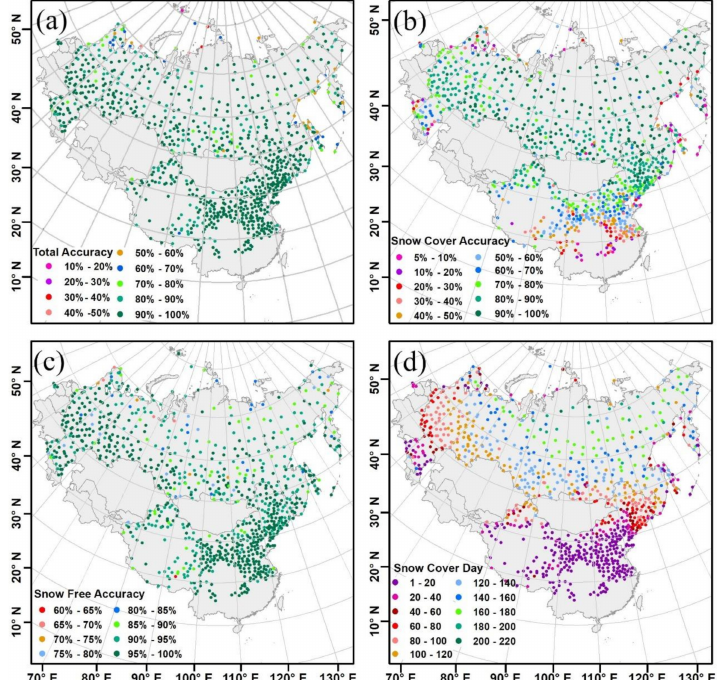
Figure 2. Validation of the daily cloud-free snow cover product using ground observation for each individual site during the period of 2000 and 2012. ( a ) Total accuracy, ( b ) Snow cover accuracy, ( c ) Snow free accuracy, and ( d ) Snow-covered